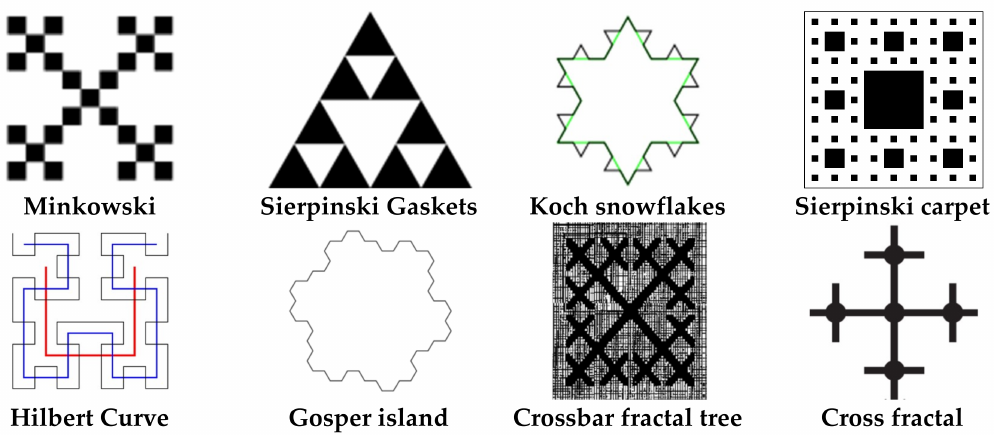
Figure 7. Some typical fractal FSS geometries investigated in different